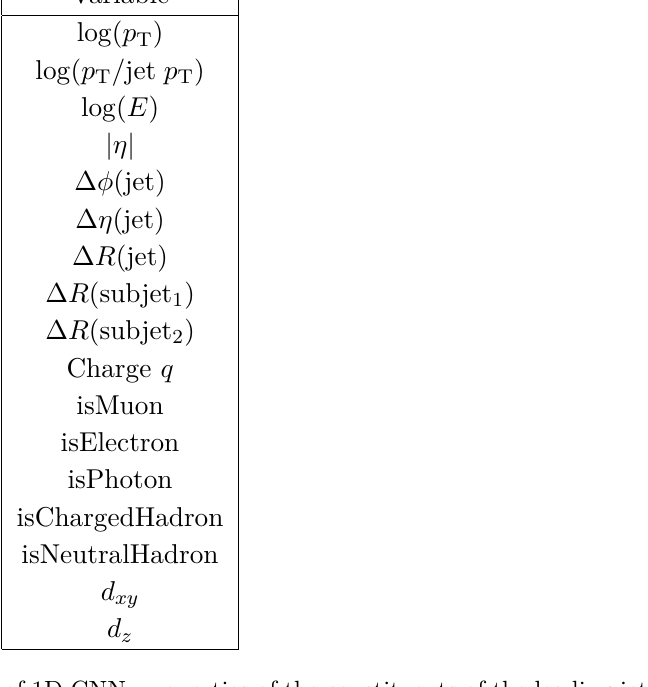
Table 2. Particle list input variables of 1D CNN, properties of the constituents of the leading jet. layer, followed by 3 recurrent layers, 2 additional input layers, and 2 dense layers at the end, shown in figure